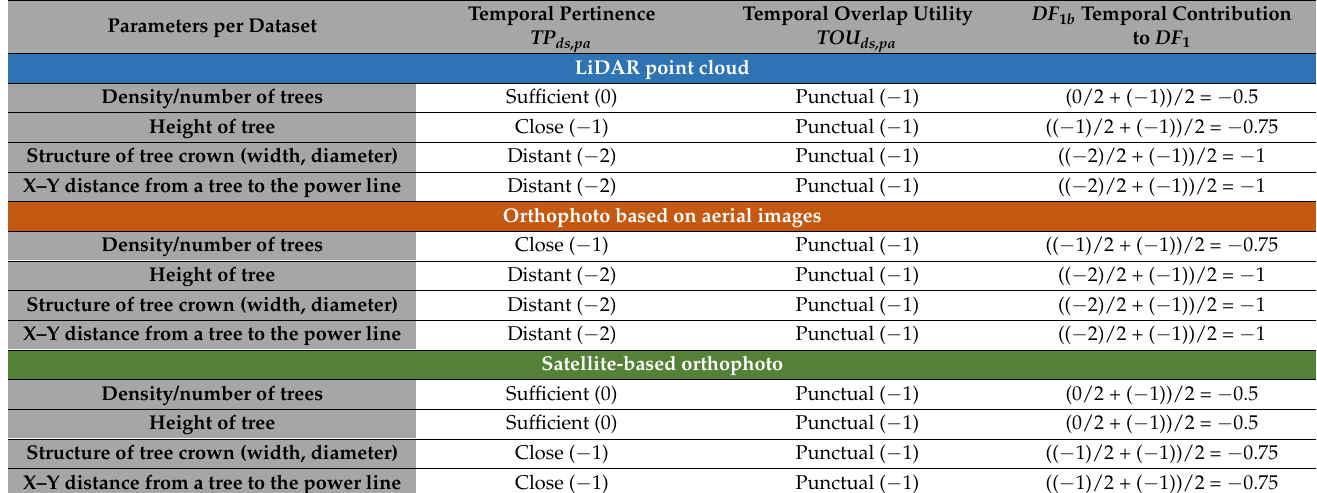
Table 23. Meta-features phase 2—temporal contribution to DF 1 per dataset per